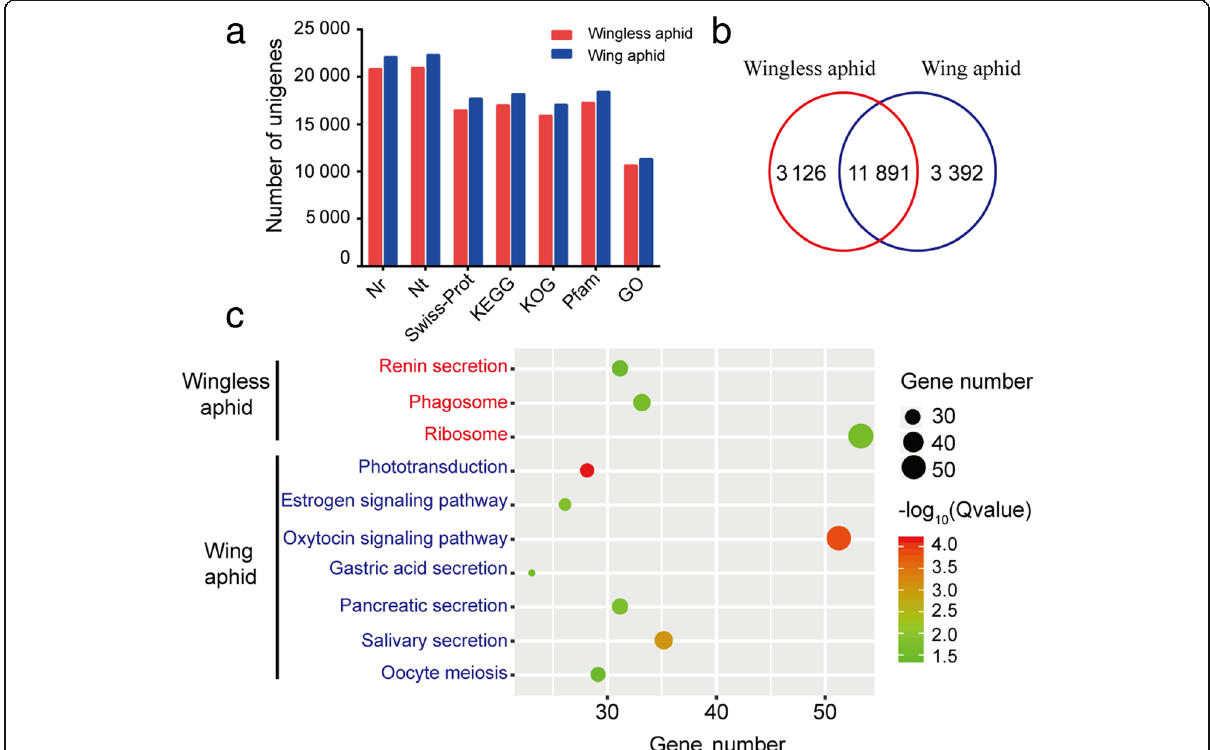
Fig. 2 Characterization of the transcriptomes of the two morphs. a Comparative analysis of the two morphs unigenes number annotated in public databases. b Venn diagram showing the distribution of genes annotated in Nr database in wingless and wing morphs. c . Functional classification of specifical genes that were annotated in Nr database in the two morphs by KEGG enrichment